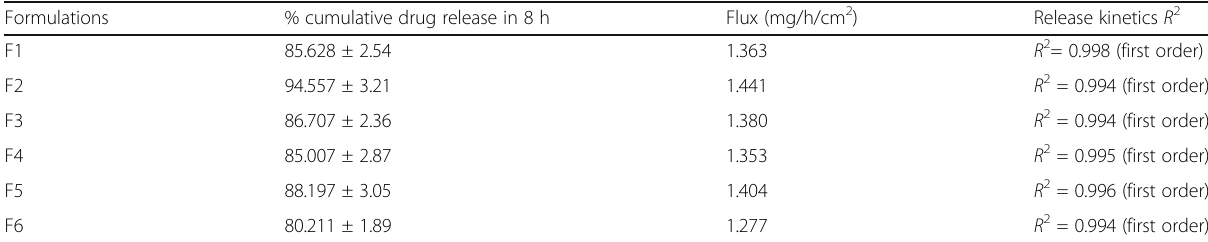
Table 4 Results of in vitro % CDR, flux, and release kinetics